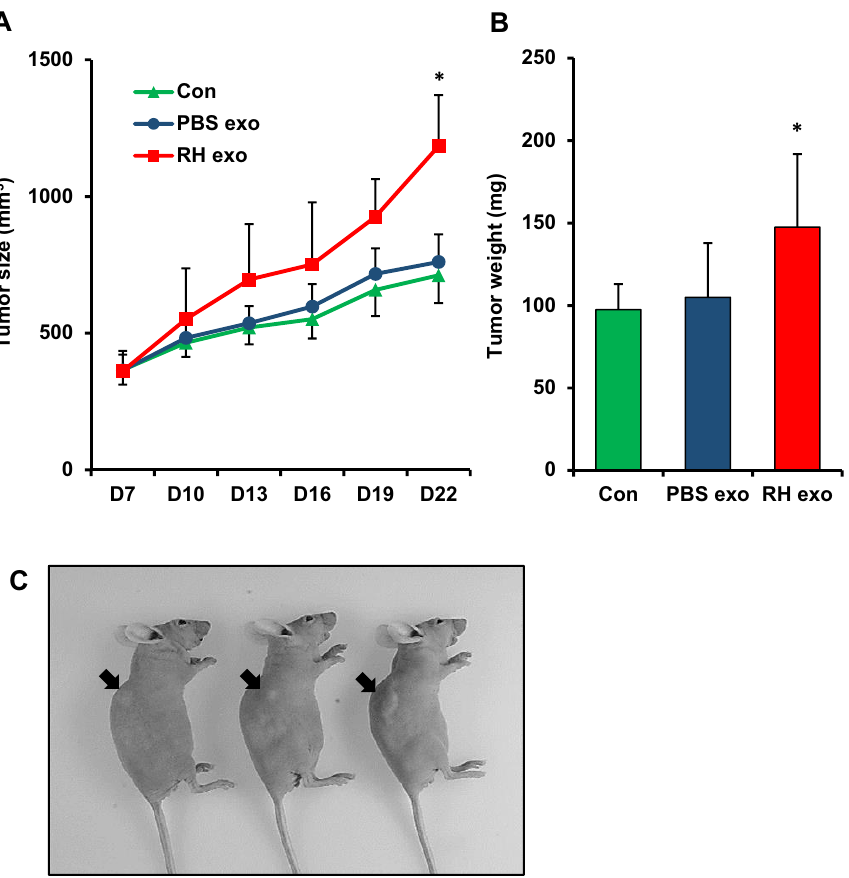
Figure 3. Tumorigenic effects of BV2-derived exosomes in U87 xenograft mouse model ( A – C ). Significantly increased tumor size ( A ) and weight ( B ) of BALB/c nude mice treated with RH-infected BV2-derived exosomes. BALB/c nude mice ( C ) were subcutaneously injected with 1 × 10 7 U87 cells suspended in a Matrigel mixture. After 6 days post-injection, 100 µg of BV2-derived exosomes were treated in the mice. Tumor size and weight were measured on the indicated days and after sacrifice, respectively. * P <